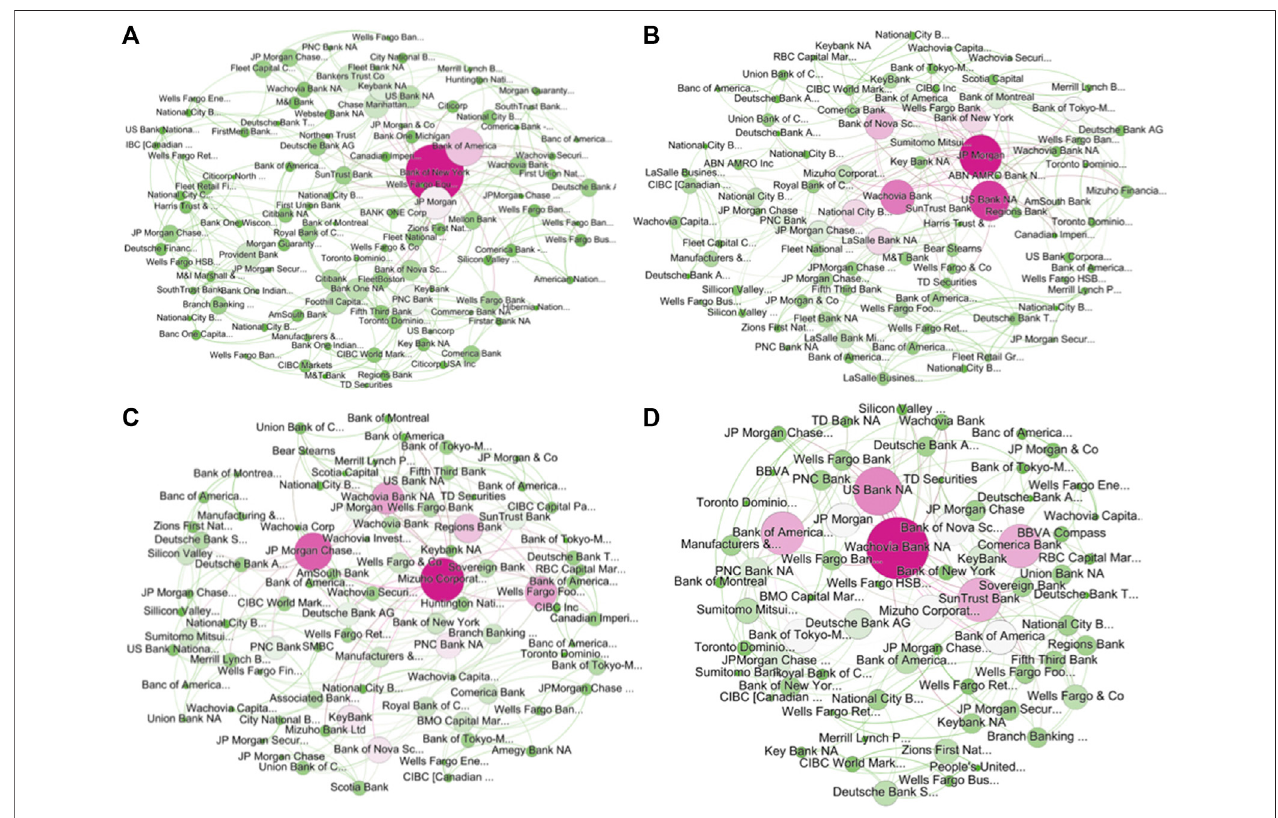
FIGURE 2 | PMFG network (A) 2002 (B) 2006 (C) 2008 (D) 2010. The nodes represent each bank, and the node size is determined by the corresponding bank ’ s degree centrality. A node with a higher degree centrality is colored pink and one with a lower degree centrality is colored light